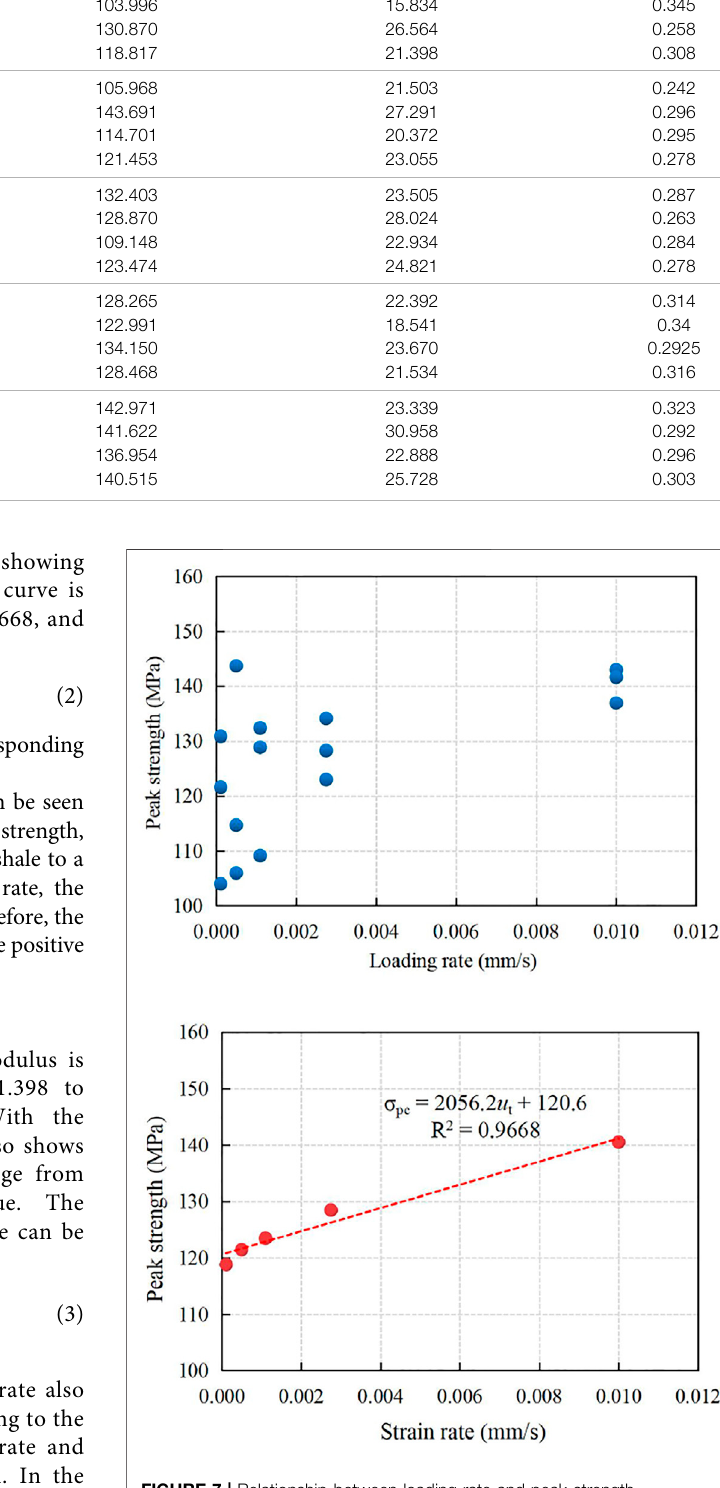
FIGURE 7 | Relationship between loading rate and peak